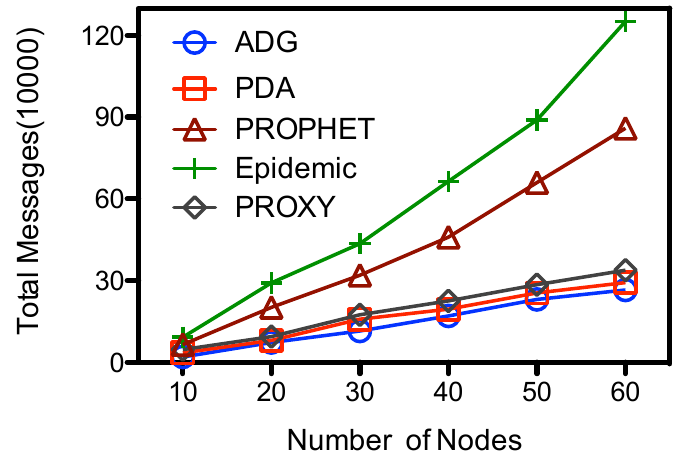
Figure 6. Number of nodes vs. total message